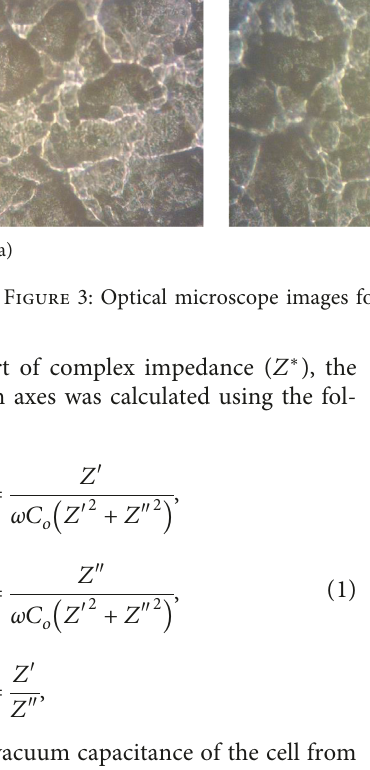
Figure 4: Dielectric constant versus frequency at ambient tem- perature for CS:POZ blend samples.